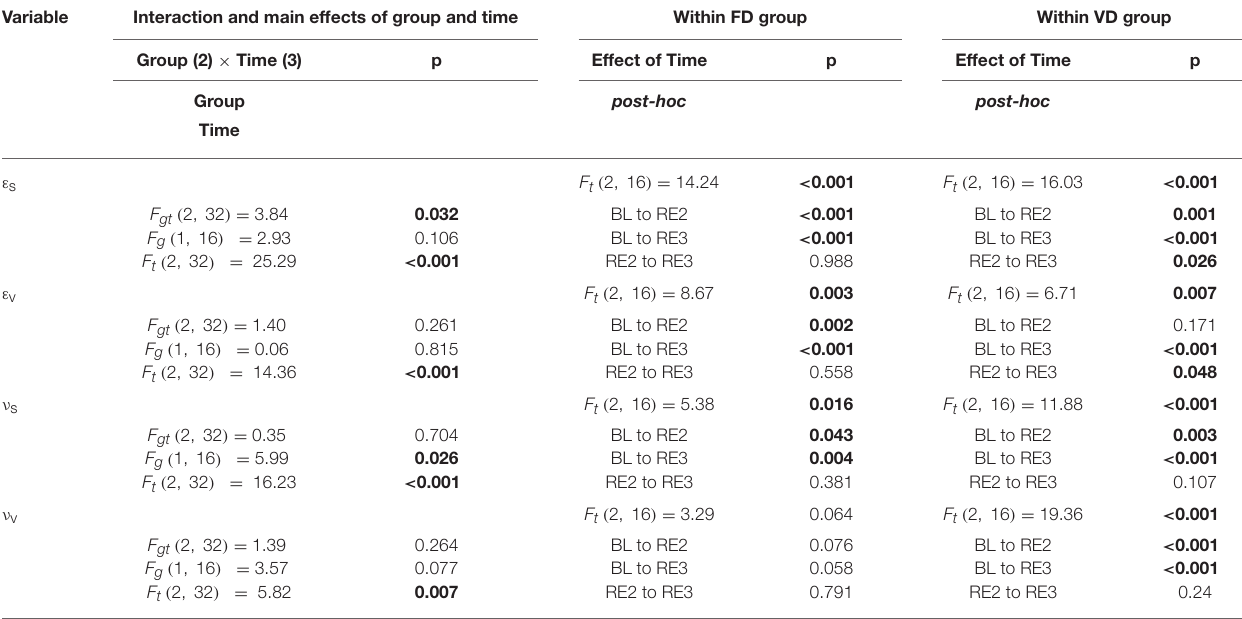
TABLE 2 | Group × Time interaction, main effects of Group (VD, FD) and Time (BL-d1100, RE2-d1100, RE3-d1100) are shown on the left column. Variable Interaction and main effects of group and time Within FD group